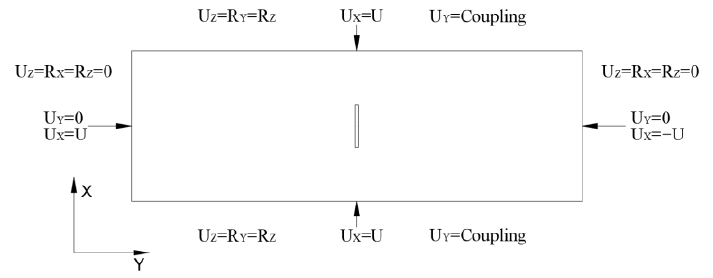
Figure 4. Boundary Conditions.